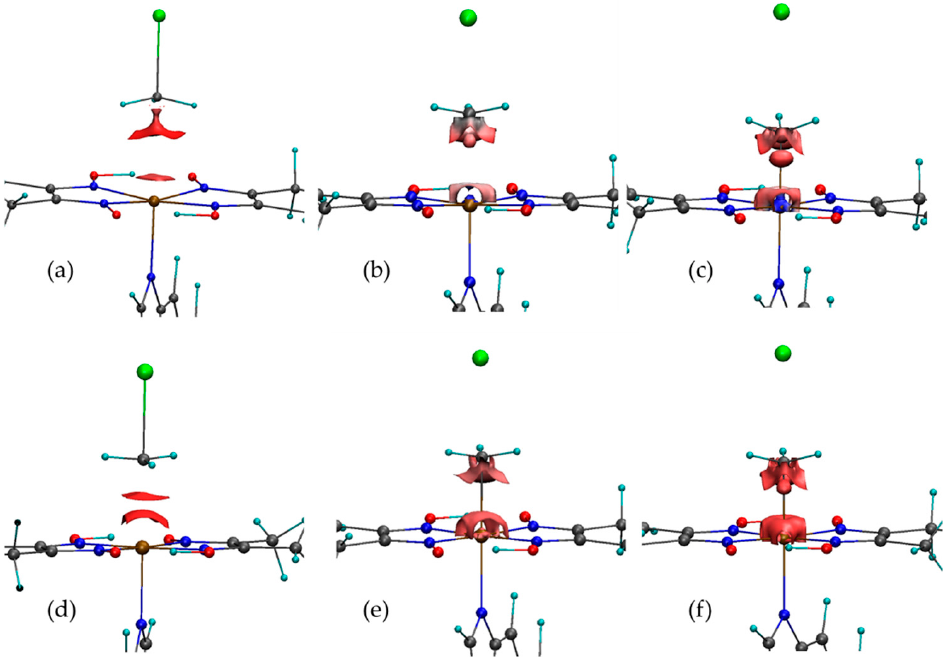
Figure 3. Representation of the χ σ computed at ( a ) ξ (isovalue = 0.200 bte), ( b ) ξ SP (isovalue = 0.341 bte), ( c ) ξ (isovalue 0.375 bte) for the reductive de halogenation mediated by Co I Cbx and at ( d ) ξ (isovalue = 0.340 bte), ( e ) ξ SP (isovalue = 0.302 bte), ( f ) ξ (isovalue = 0.340 bte) for the reaction mediated by Co II Cbx. C atoms are in gray, with Co in ochre, N in blue, O in red and Cl in green.